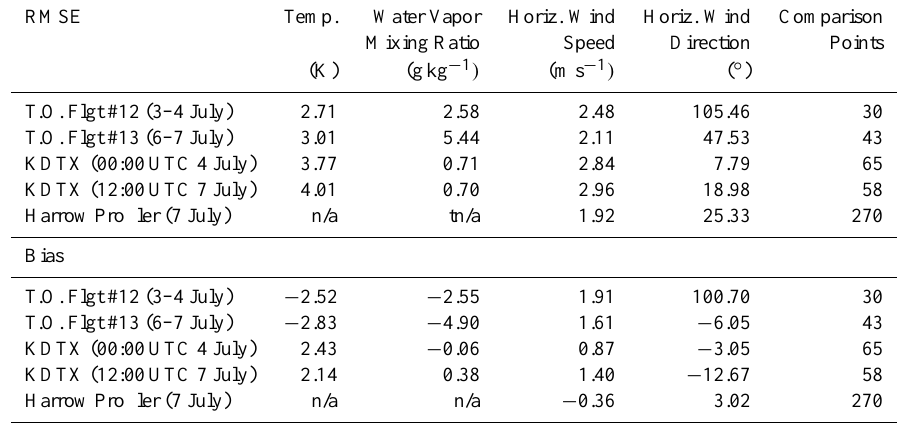
Table 2. RMSE (top) and mean bias (bottom) of model estimates for selected variables vs. verification datasets including aircraft data (T. O.=“Twin Otter”), radiosonde (KDTX) and a VHF wind profiler (Harrow Profiler).